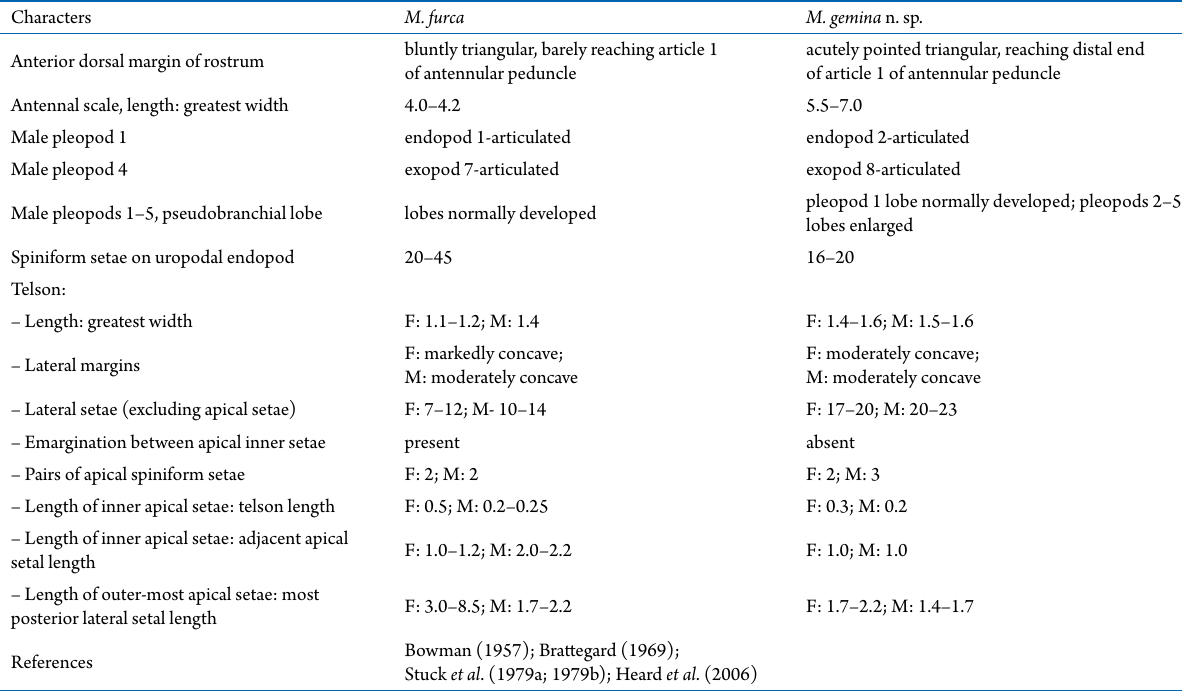
Table 1. Comparison of diagnostic characters of Mysidopsis furca Bowman, 1957 and Mysidopsis gemina n. sp.